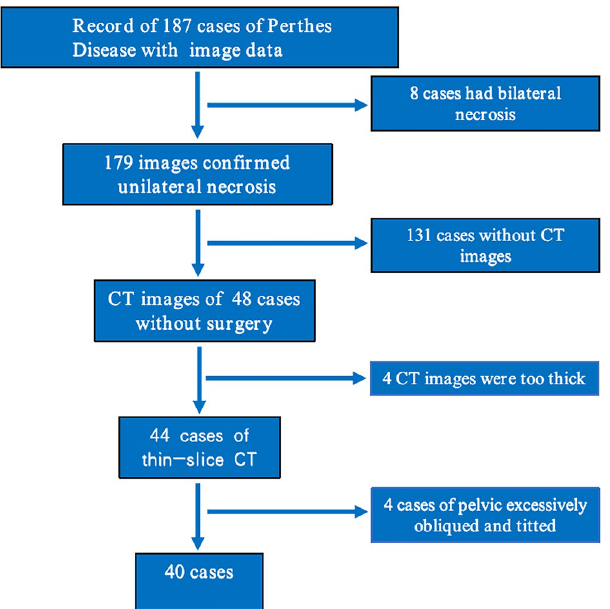
Figure 1. screening flow chart of case group. (Adobe Illustrator Cs6, Version 16.0.0, URL: https:// www. adobe. com/ cn/ produ cts/ illus trator.